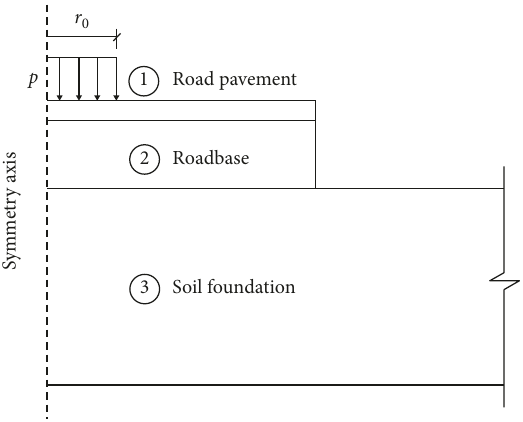
Figure 3: Schematic plot of road